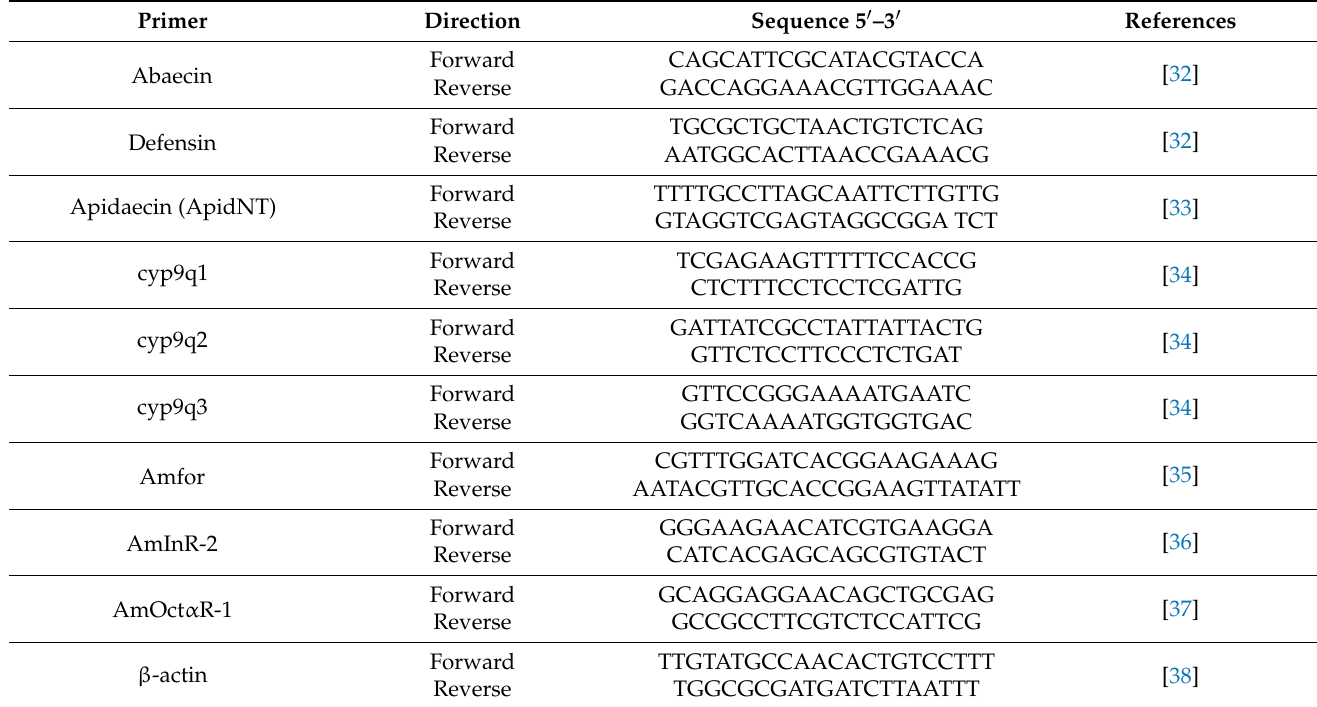
Table 1. The forward and reverse primers of genes used in